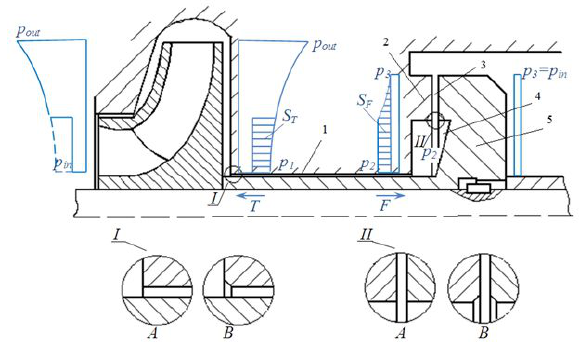
Figure 1: Scheme of typical automatic balancing device of centrifu- gal